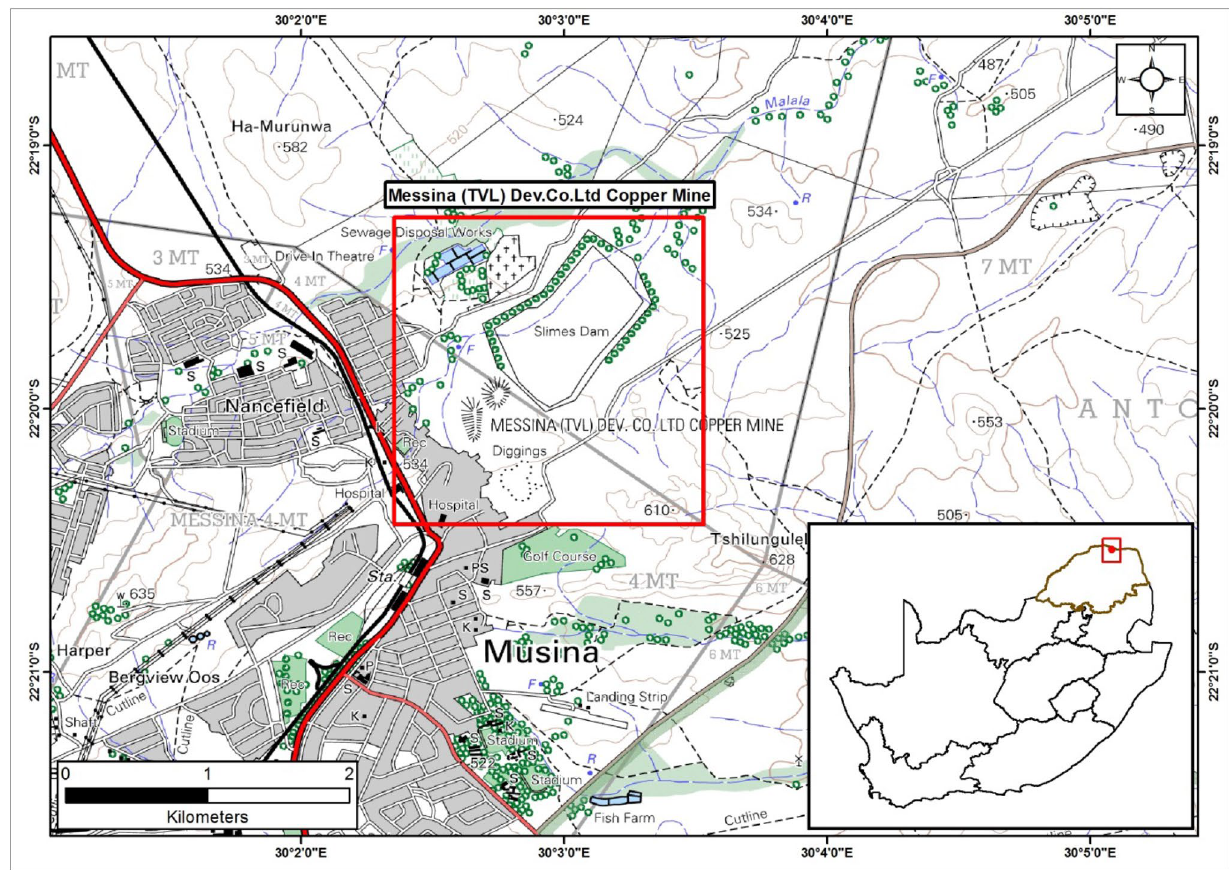
Fig. 1 Locality map of the study area at Musina, showing Musina town, its surrounding townships and the location of Musina copper mine (adapted: